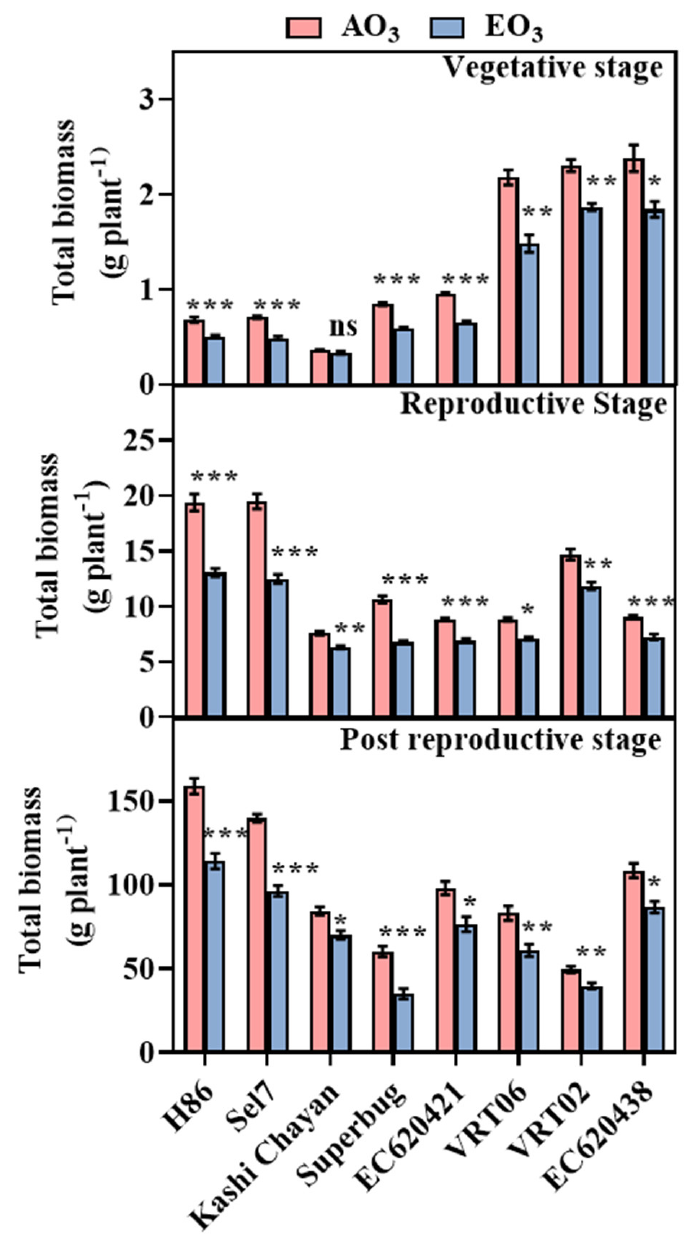
Figure 4. Variations in plant biomass of tomato cultivars under ambient O 3 (AO 3 ) and elevated O 3 (EO 3 ) treatments at different growth stages. Values are mean ± SE. Level of significance between AO 3 and EO 3 based on t test: * p ≤ 0.05; ** p ≤ 0.01; *** p ≤ 0.001; ns not significant.